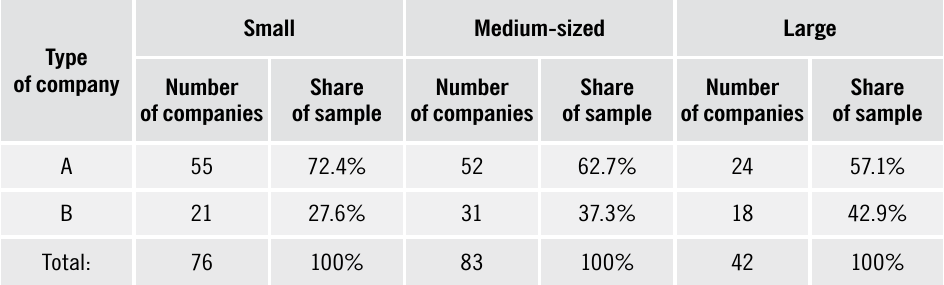
Two types of companies versus their